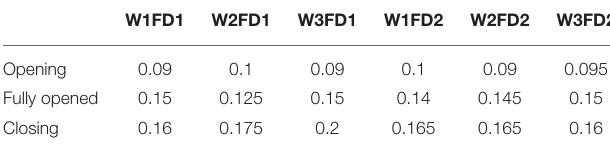
TABLE 3 | The lasting time of different stages for the six cases